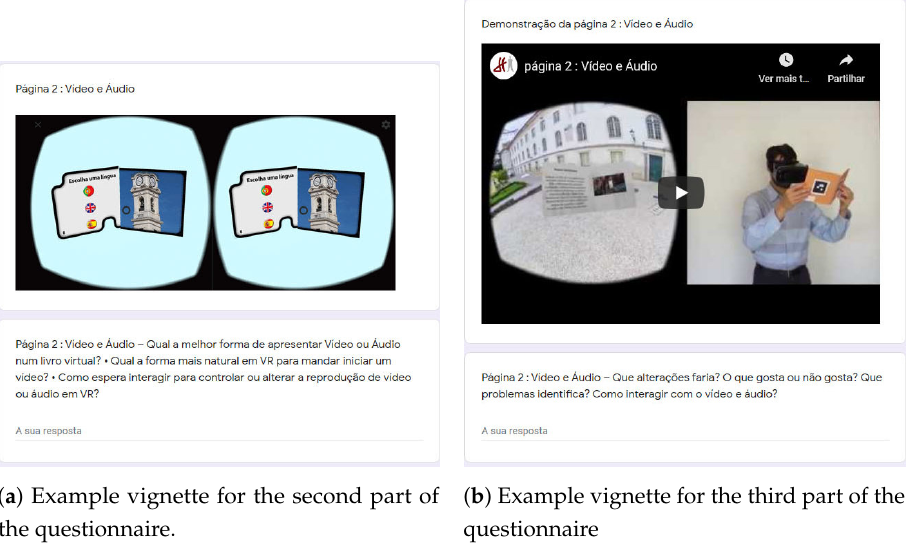
Figure 8. Example vignettes for the second and third parts of the